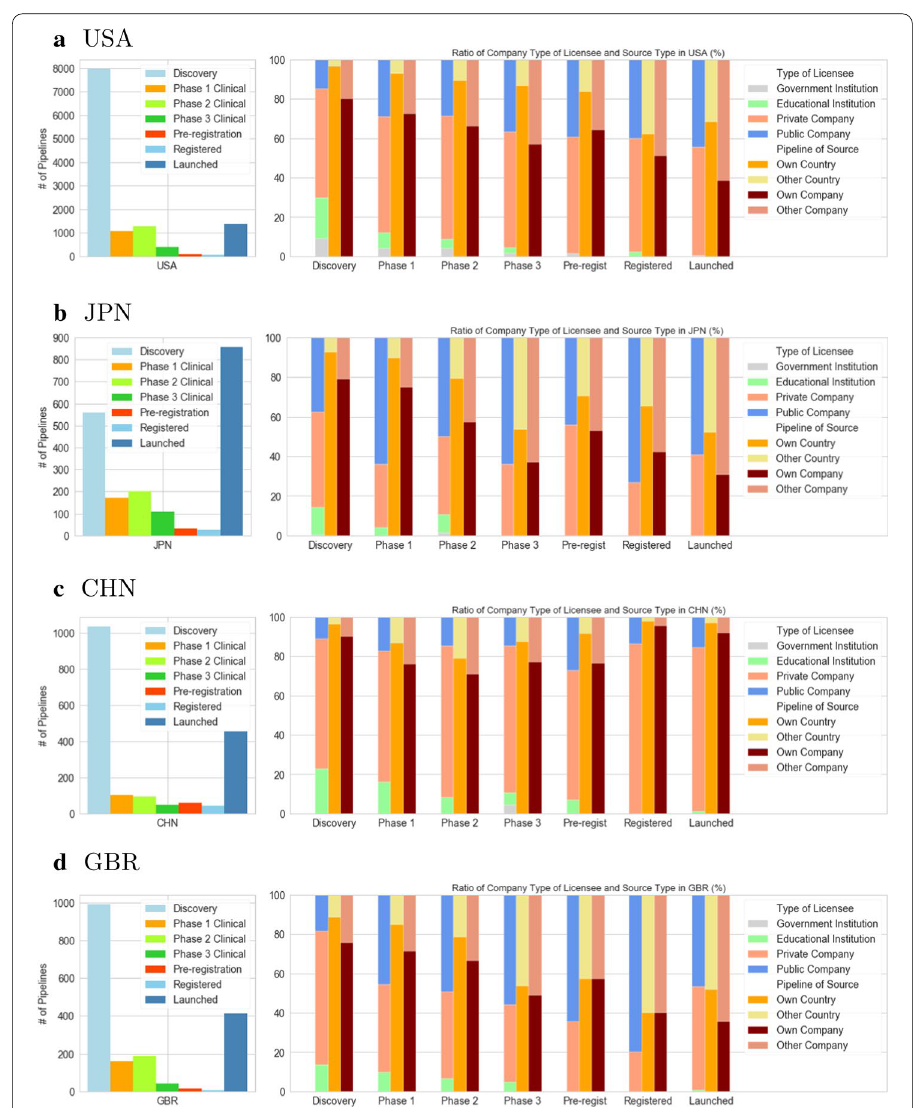
the number of drug pipelines discovered by each country. In contrast, “other country” represents the number of drug pipelines at certain statuses by each country, where a different country discovers them. Similarly, “own company” in the legend represents the number of drug pipelines discovered by each country’s own company. “Other company” represents the number of drug pipelines at certain status by each country, where the different company discovers them from these